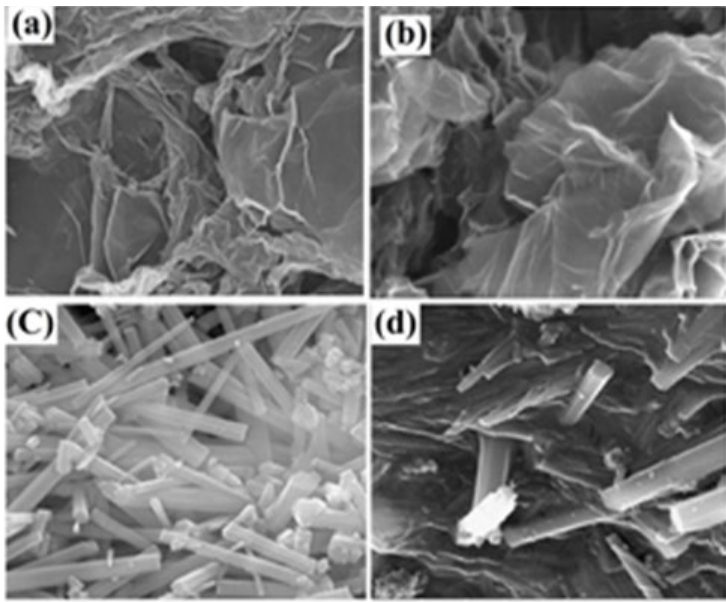
Fig. 5: SEM micrographs of (a) GO (b) NG (c) CoFe Fig. 5 SEM micrographs of (a) GO, (b) NG, (c) CoFe 2 O 4 and (d) NG@CoFe 2 O 4